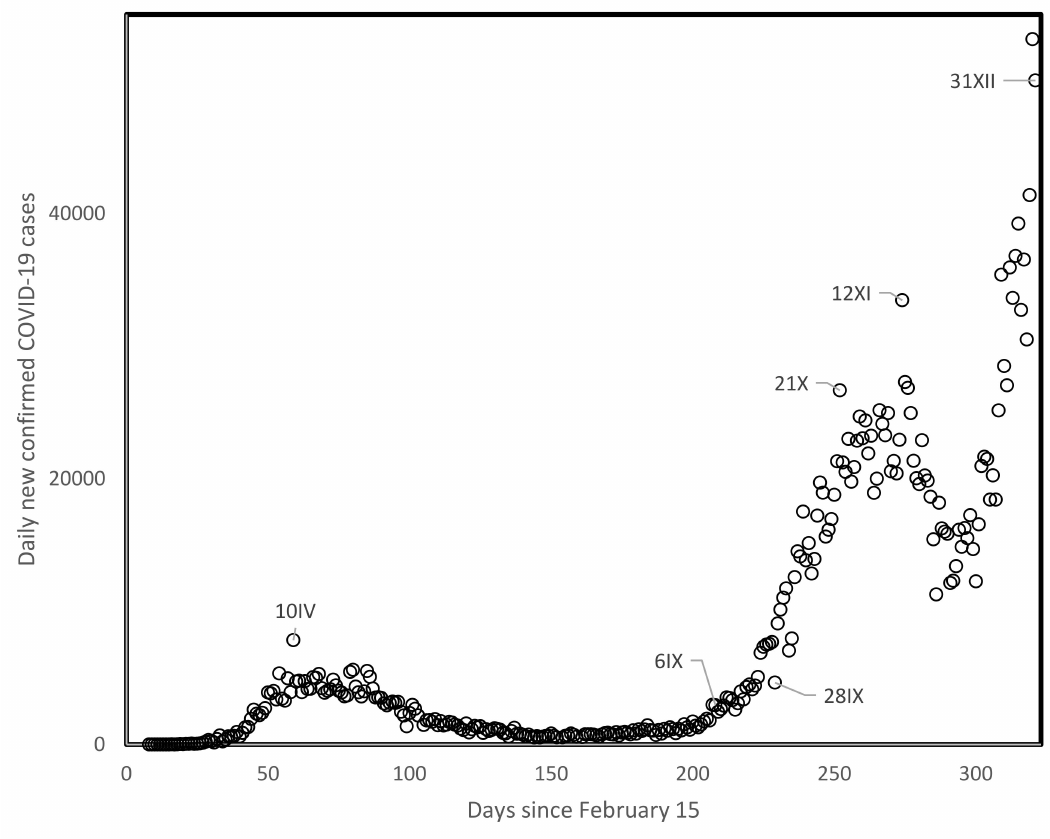
Figure 4. Daily new confirmed COVID-19 cases in the UK since 15 February 2020 until the end of 2020. The dates, with months counted in roman numbers are indicated for specific